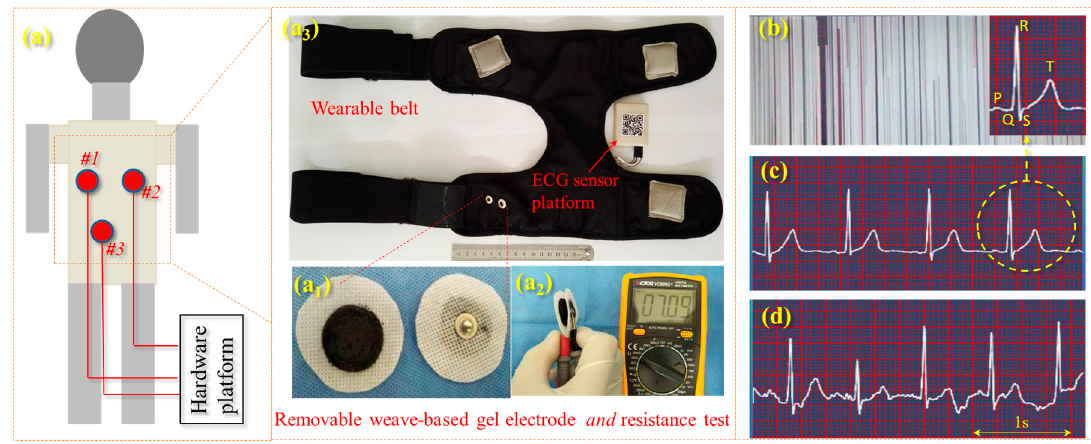
Figure 7. ECG acquisition process: ( a ) electrode distribution on the human body where ( a 1 ) shows our self-developed conductive hydrogel-based electrodes, ( a 2 ) shows the tested resistance of a pair of electrodes, and ( a 3 ) shows the self-developed ECG monitoring belt and integrated circuit for signal processing; ( b ) ECG noise when the belt does use the developed gel electrode, the inset shows a typical unit of ECG signal with characteristic waves of P, Q, R, S, and T respectively; ( c ) ECG signal for a human in a static state; and ( d ) the ECG signal for a human in a walking state. The scale bar represents 0.25 s per unit length for recording the heart rate.